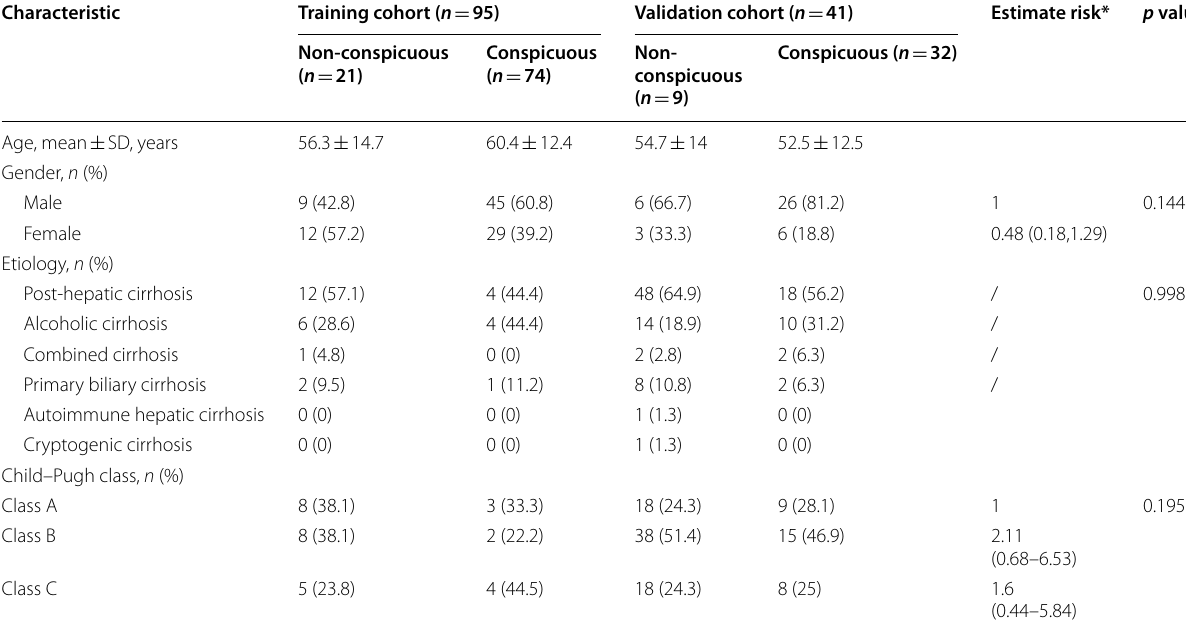
n : number of patients, age values were expressed as mean